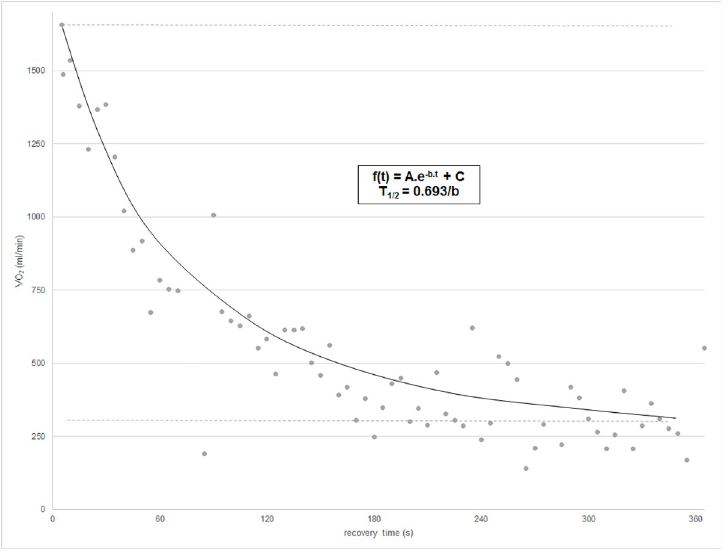
Fig 1. Example of VO 2 response after maximal exercise. Data is fitted to a mono-exponential curve, as shown, and half-life time is calculated.